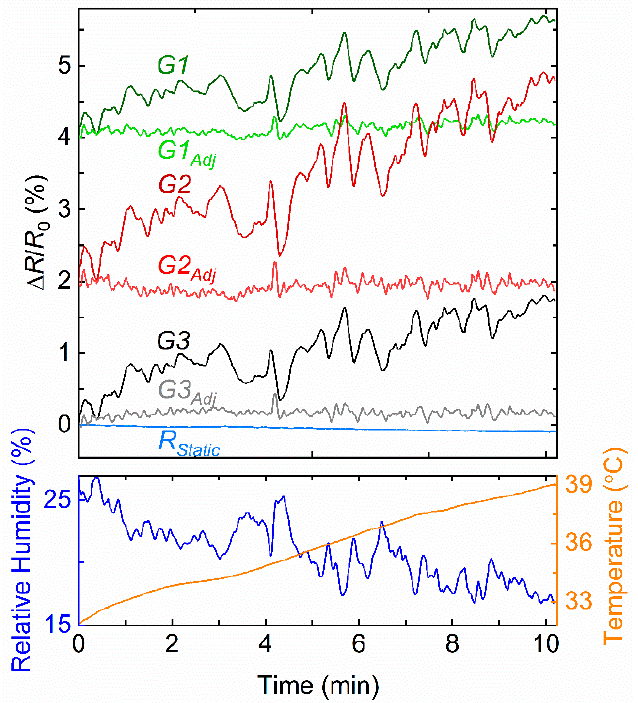
Figure 7. The sensing platform located outdoor allows us to remotely monitor the signal ( ∆ R / R 0 ) of three graphene sensors, G1, G2 , and G3 , one static resistance R Static (top panel), as well as the ambient relative humidity and temperature provided by the TH sensor (bottom panel). Equation (1) is used to decrease the effects of the change in humidity and temperature on G , to obtain the adjusted signal G adj . A vertical offset of 2% for G2/G2 adj and 4% for G1/G1 adj is added for clarity.